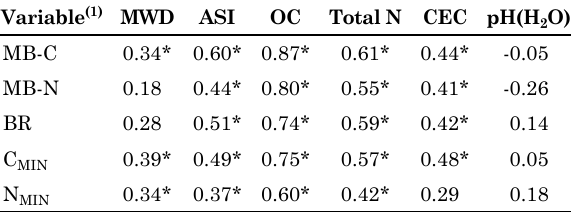
Table 5. Pearson’s correlation coefficients between soil microbial, physical and chemical properties 24 years after forest conversion to a perennial crop with coffee or annual grain crops (maize and soybeans) in conventional tillage or no-tillage variable (1) MWD